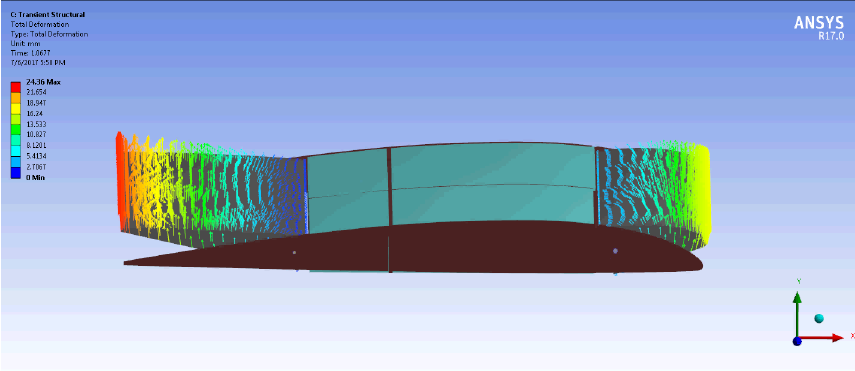
Figure 8. Leading edge and trailing edge angular position variation produced by the actuation system.